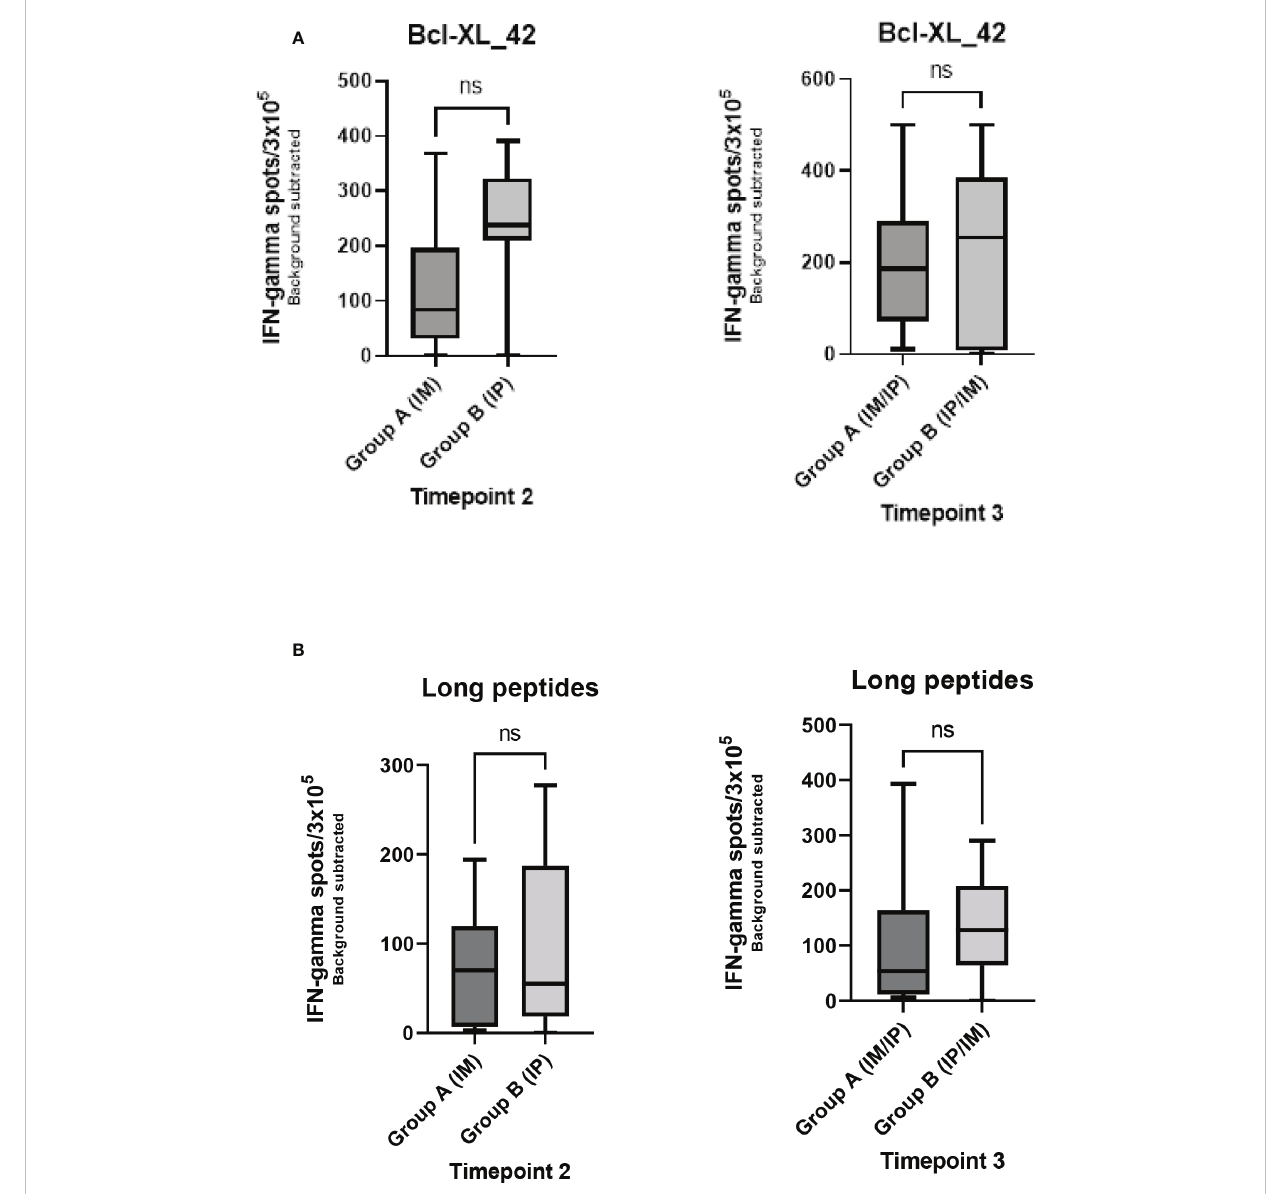
FIGURE 4 Comparison of Elispot data between group A and B at TP2 and TP3 for either stimulation with (A) the vaccination peptide (Bcl-XL-42) or (B) HLA class II predicted long peptide pool. Mann-Whitney U test was used to compare ranks of unpaired observations. No signi fi cant changes were found between groups A and B at any time points. ns meaning not signi fi